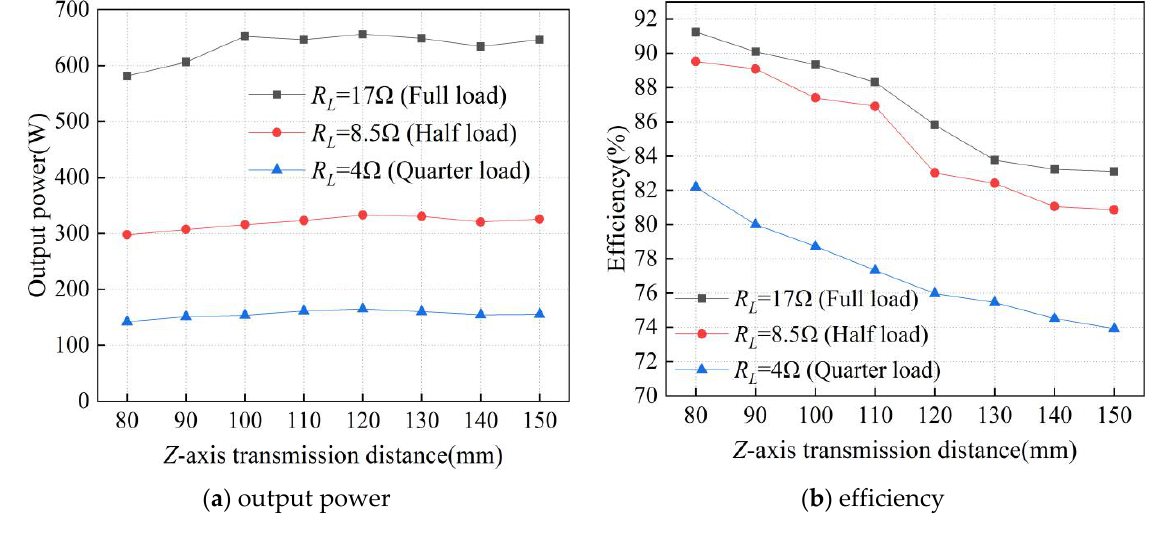
Figure 16. Measured output power and efficiency versus transmission distance. Table 2. Comparison of traditional control schemes and existing hybrid